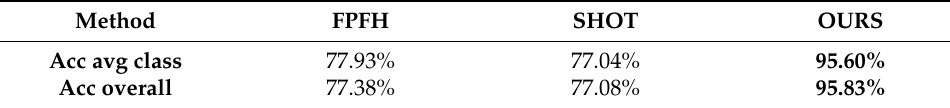
Table 2. Accuracy of different methods.